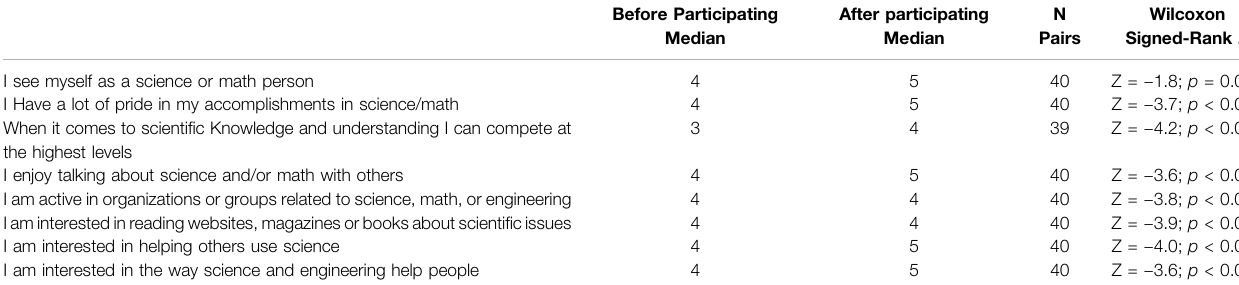
TABLE 11 | Analysis of responses to items related to STEM